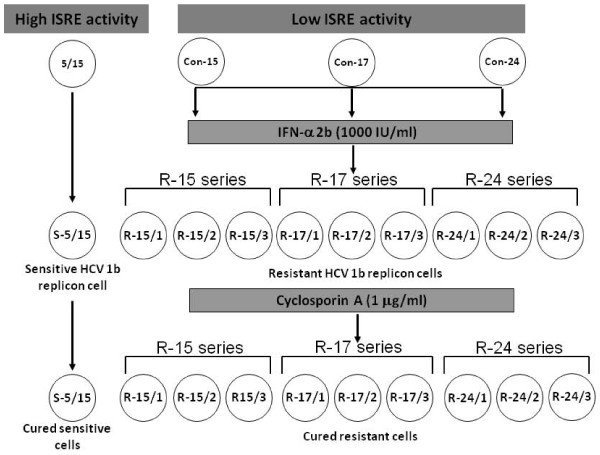
Schematic diagram showing the isolation of IFN-α resistant and sensitive replicon cell lines. Three different HCV 1 b sub-genomic replicon cell lines (Con-15, Con-17 and Con-24) with low ISRE-luciferase activity were cultured in growth media supplemented with G-418 (1 mg/ml) and IFN-α 2 b for more than 4 weeks. Resistant cell colonies that survived the IFN-α 2 b treatment were picked and stable resistant cell lines (R-15, R-17 and R-24 series) were established. Cured Huh-7 cell line from each replicon was prepared by repeated treatment with cyclosporine A (1 μg/ml). All of the cured Huh-7 cells were free from HCV and still maintained low level ISRE-luciferase activity after IFN-α 2 b treatment. 5/15 cell line is IFN-α sensitive HCV 1 b replicon cell line. HCV replication in this cell line was eliminated by IFN-α 2 b and used as the positive control.